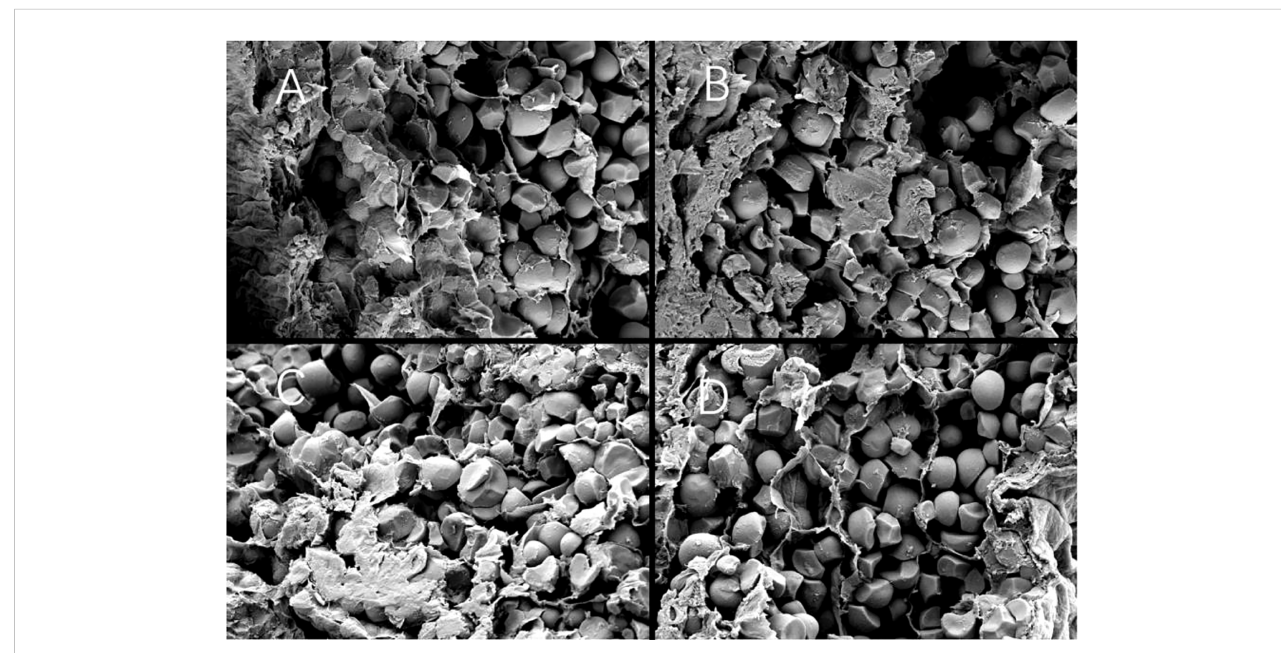
FIGURE 7 (A) Y28, (B) N5718, (C) W113 and (D) Y5118 (at